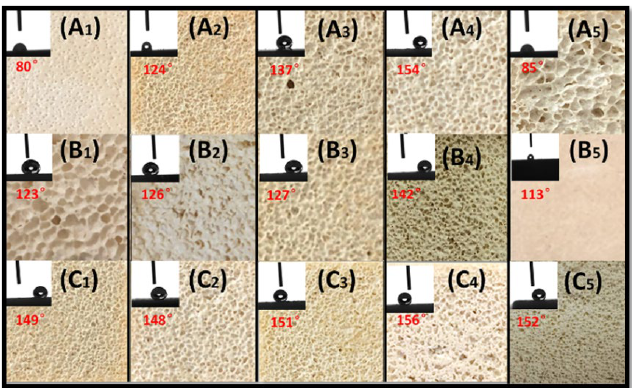
Figure 9. The water contact angle of different ratios of F-MOC (( A 1 )–( A 5 ) are FAS content of 1%, n (FAS): n (TEOS) = 1:8, the addition of H 2 O 2 increased from 4% to 12%, ( B 1 )–( B 5 ) were when the additional amount of H 2 O 2 was fixed at 10%, and the TEOS content increased from n (FAS): n (TEOS) = 1:6 to n (FAS): n (TEOS) = 1:14, ( C 1 )–( C 5 ) were the additional amounts of H 2 O 2 fixed at 10%, n (FAS) : n (TEOS) = 1:8, the FAS content increased from 0.5% to 2.5%).